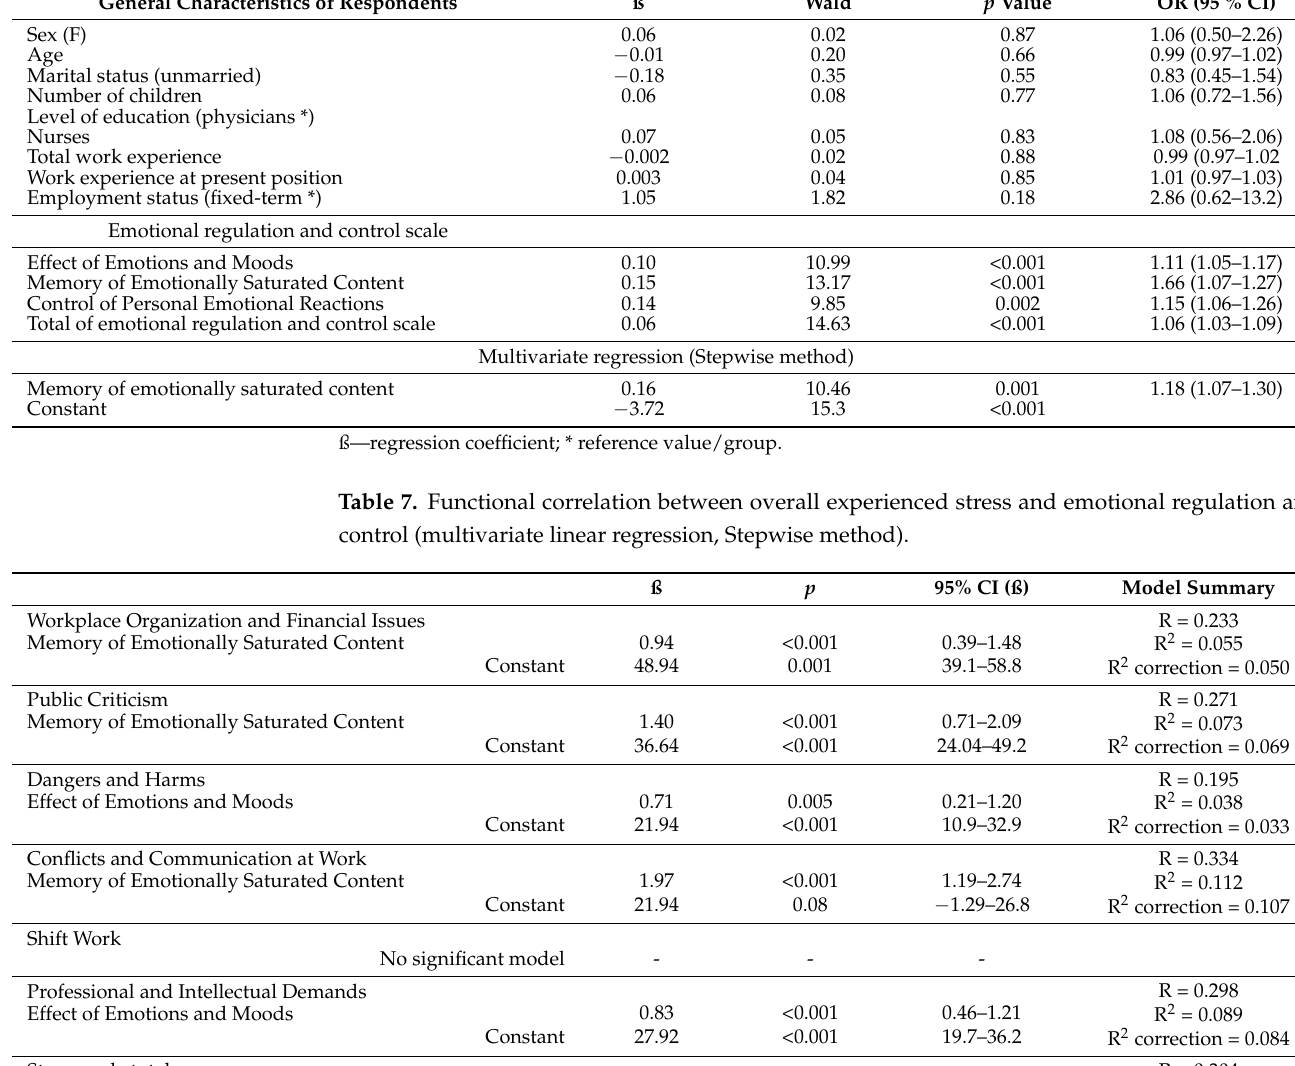
Table 6. Predicting probability of severe stress (bivariate and multivariate regression analysis). Bivariate Regression